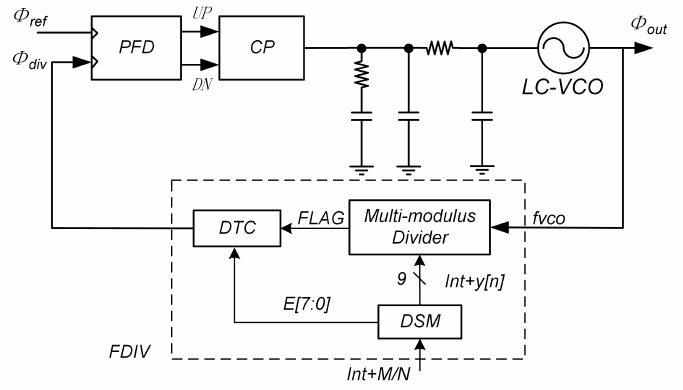
Figure 3. Diagram of the proposed PI fractional